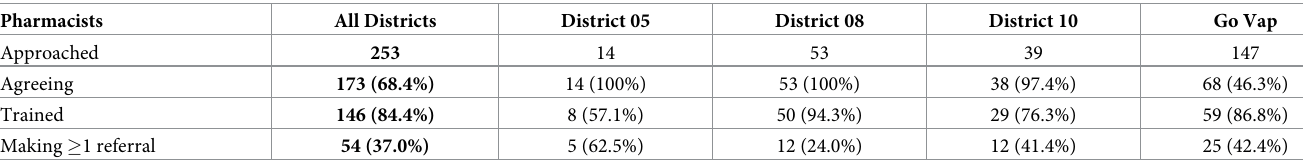
Table 1. In-person recruitment of pharmacists in the referral pilot by district.